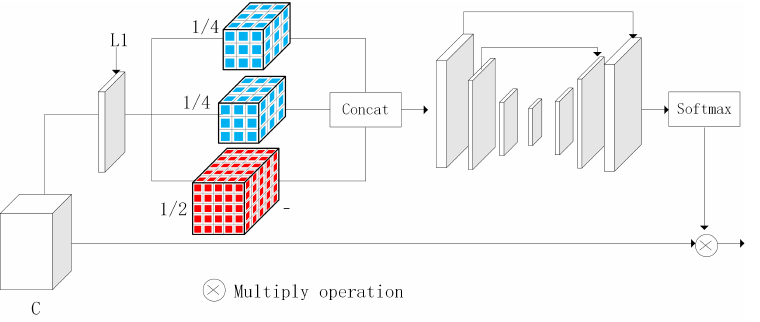
Figure 3. Multi-scale cost attention structure, where c represents the cost after cost construction and L1 represents deformable